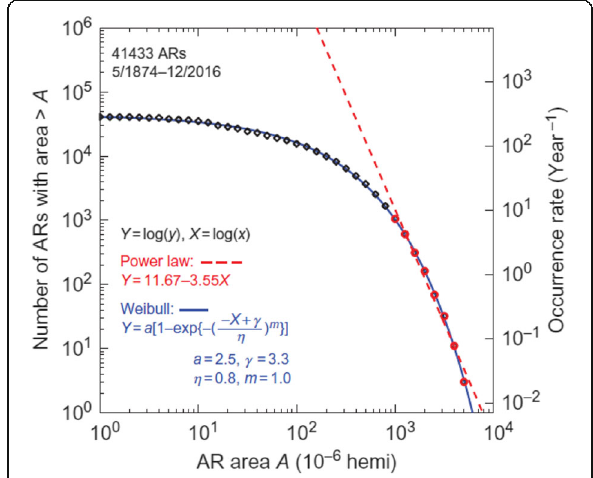
Fig. 3 Cumulative number N of active regions ’ (sunspot groups ’ ) areas A from 1874 to 2016. A is expressed in msh (millionths of solar hemisphere). The left-hand Y -axis gives the total number of active regions with area > A , and the right-hand Y -axis — the occurrence rate N per year (taken from Gopalswamy 2018) potential energy that can be converted into magnetic kinetic energy. The visual indicators of active regions are sunspots.